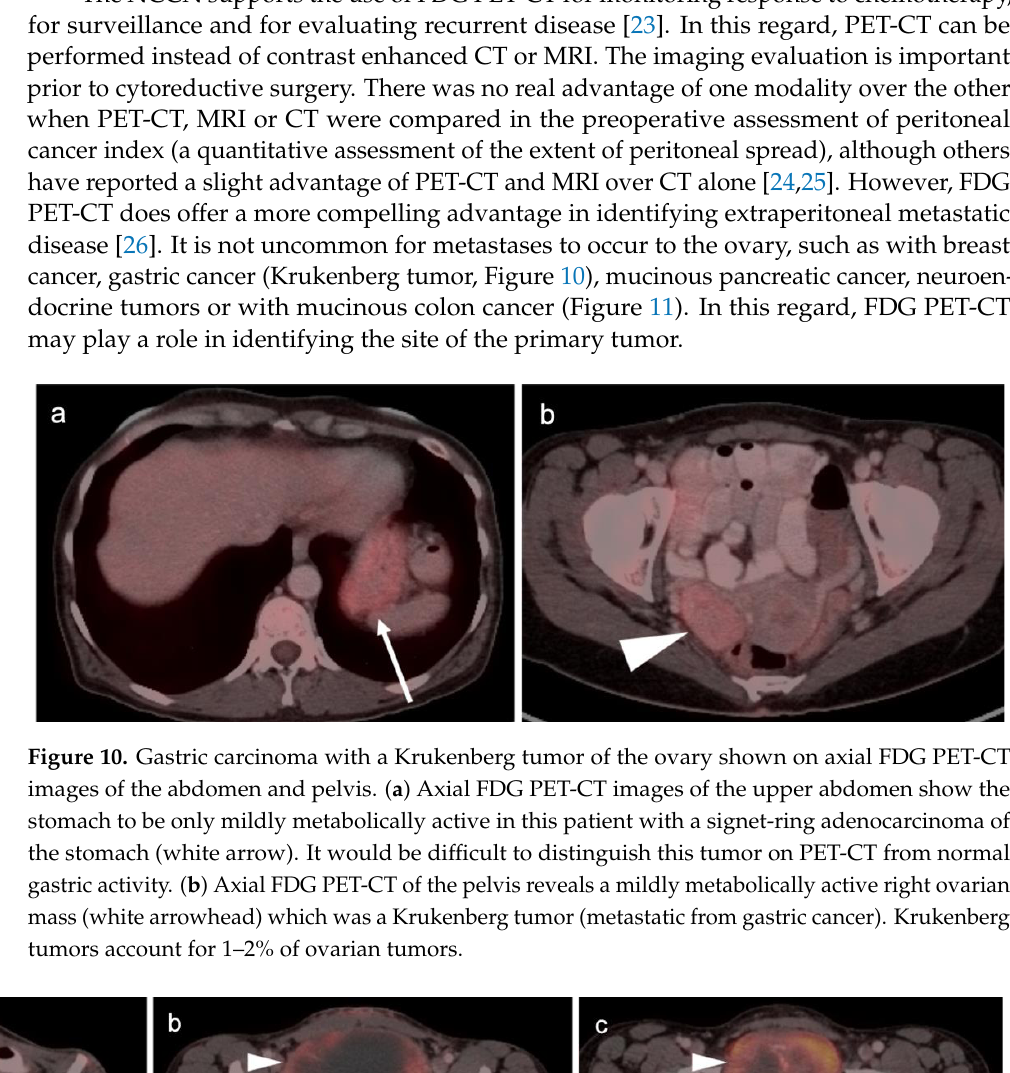
Figure 11. Mucinous adenocarcinoma of the colon metastatic to the ovary shown on axial FDG PET-CT images of the pelvis. ( a – c ) Axial FDG PET-CT images of the pelvis. There is a hypermetabolic, centrally cystic tumor in the pelvis (white arrowheads), which at surgery was a large metastasis to the ovary from a colon cancer. The ovaries represent a common site for metastatic disease for many tumors, including from colon cancer. This mucinous adenocarcinoma metastasis to the ovary is very similar in appearance on FDG PET-CT to primary ovarian mucinous